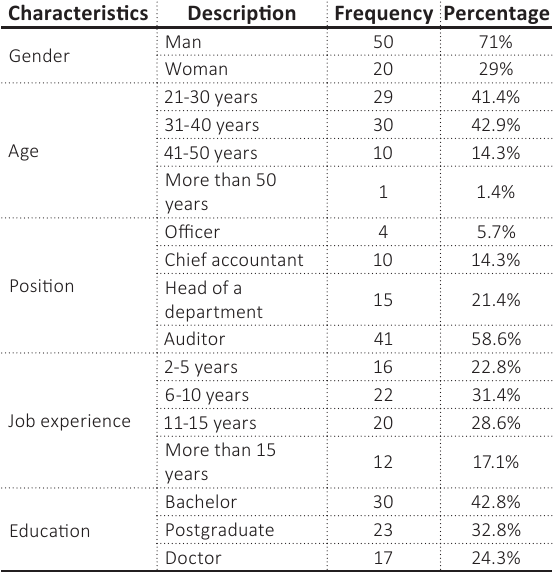
Table 1. Descriptive statistics of respondents Characteristics